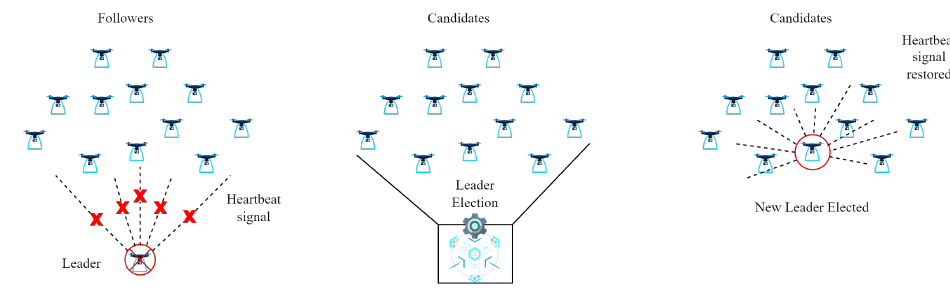
Figure 1. A visualization of leader-election